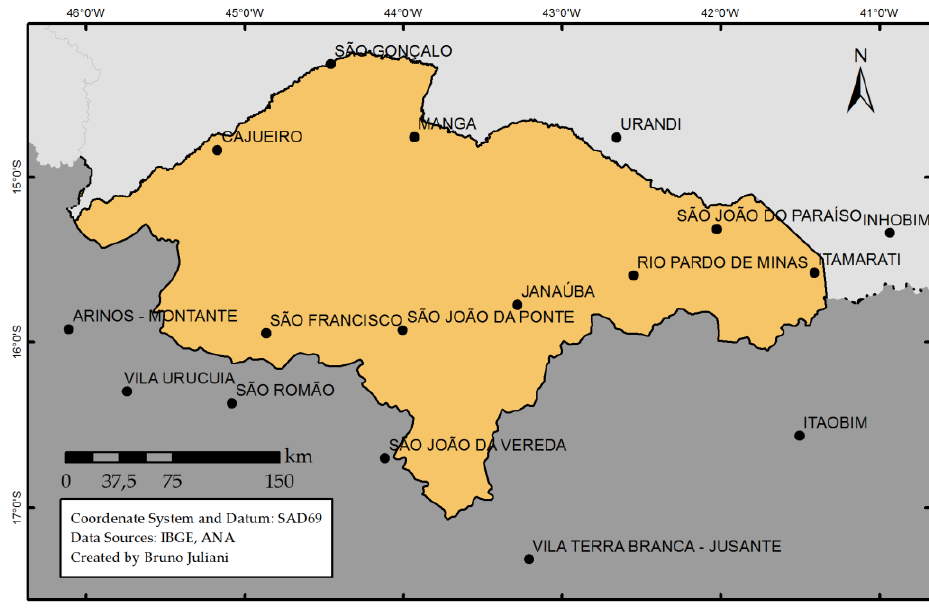
Figure 2. Selected stations for drought analysis